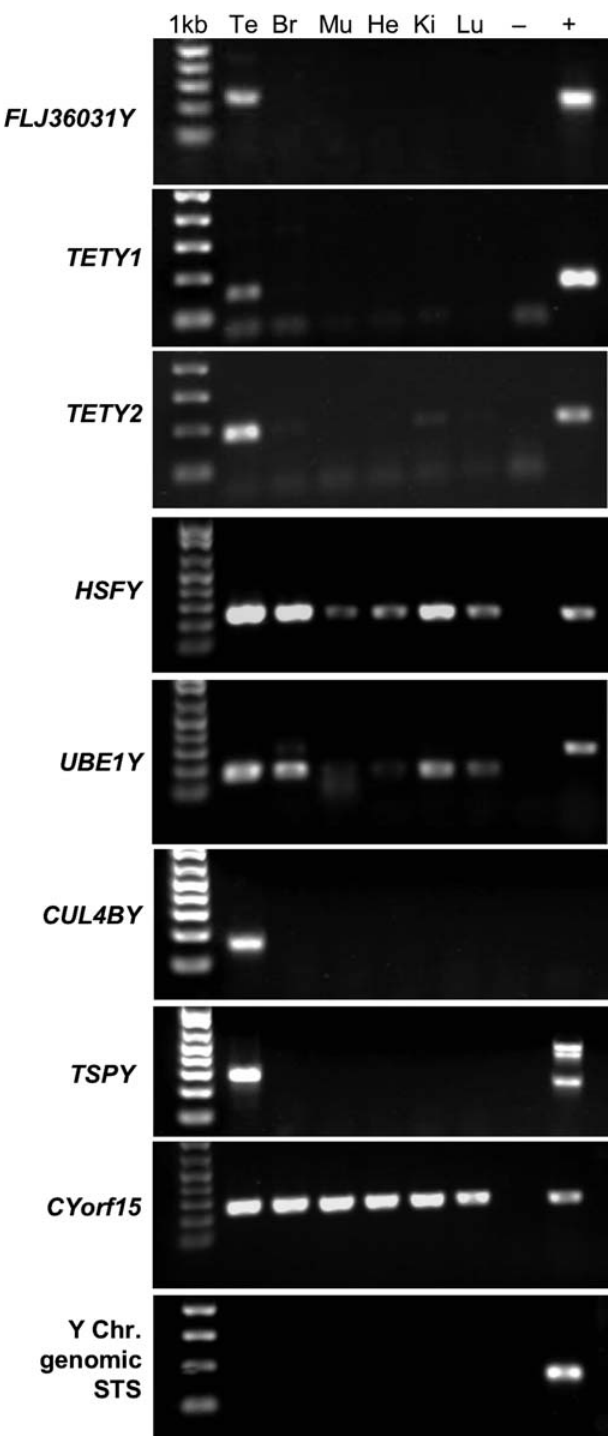
Figure 6. Testis-Specific Transcription of Feline Multicopy Y Chromo- some Genes Amplification results of PCR primers specific for nine feline genes/ sequences are shown in a panel of six adult domestic cat mRNA samples: Te, testis; Br, brain (cerebrum); Mu, muscle; He, heart; Ki, kidney; Lu, lung; (cid:2) , no mRNA control; þ , male domestic cat genomic DNA control. Each reaction contains 10 ng of mRNA. The gene being assayed is listed to the left of each frame. No background genomic DNA amplification was detected using a noncoding Y chromosome genomic STS marker. Negative RT reactions were also run for each STS marker and showed no amplification (unpublished data). All feline multicopy genes show